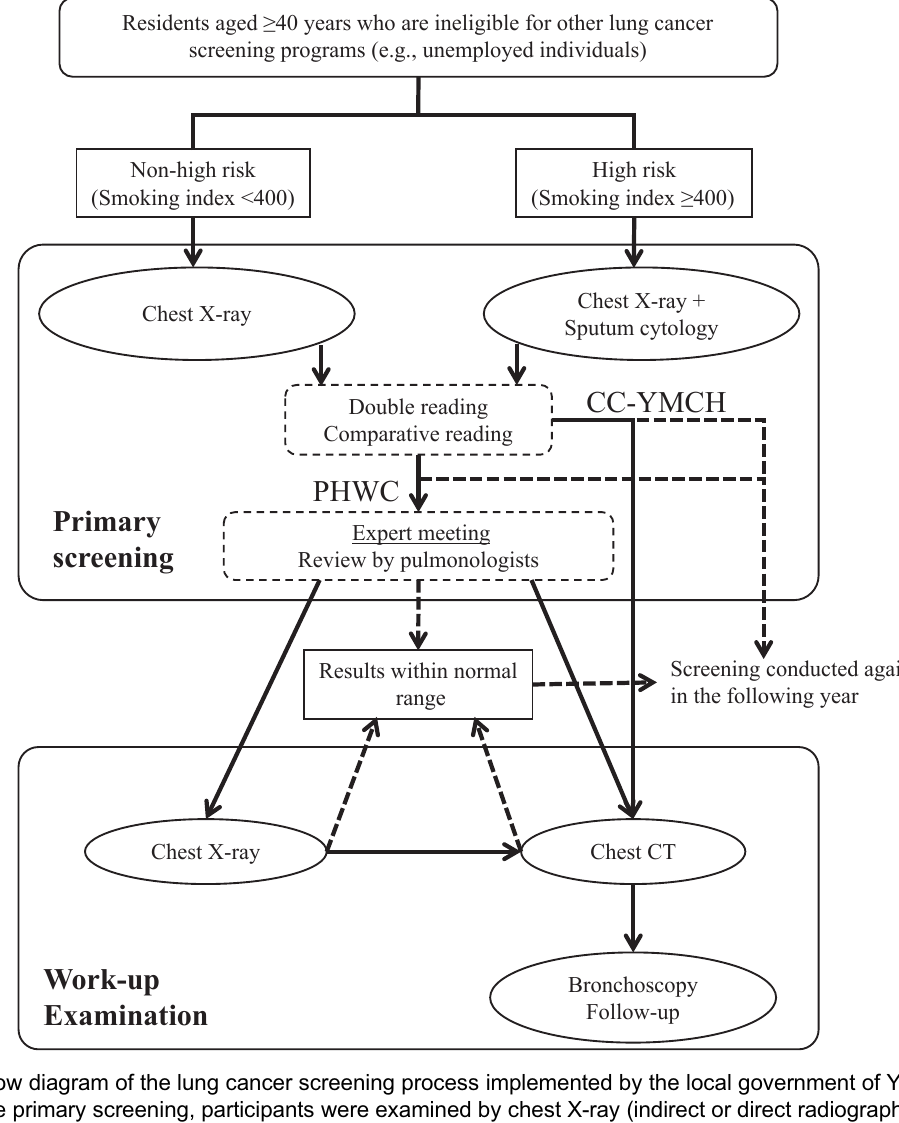
Figure 1. Flow diagram of the lung cancer screening process implemented by the local government of Yokohama City. In the primary screening, participants were examined by chest X-ray (indirect or direct radiograph), with or without additional sputum cytology test. There were two lung cancer screening systems: one was performed in the 18 Public Health and Welfare Centers (PHWC), and the other was in the Cancer Center of Yokohama Municipal Citizen ’ s Hospital (CC-YMCH). If participants had positive results (e1, e2, and d) in the primary screening, they were asked to undergo work-up examinations, such as chest X-ray (direct radiograph), chest computed tomography (CT), and